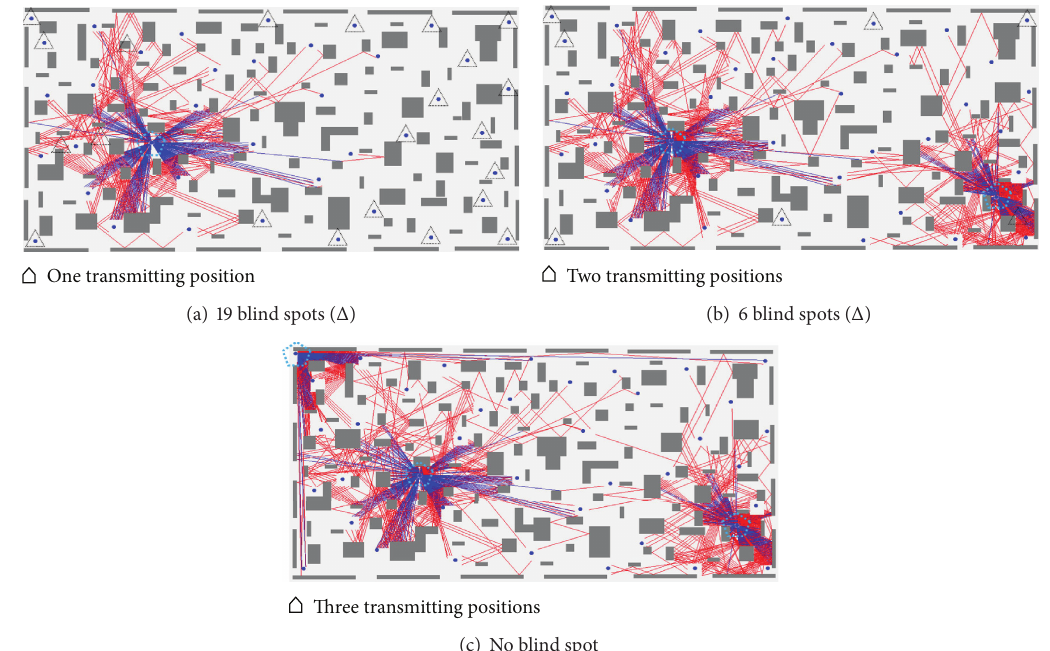
Figure 1: Blind spots ( Δ ) identification and elimination from 40 sampling points deployed in an indoor